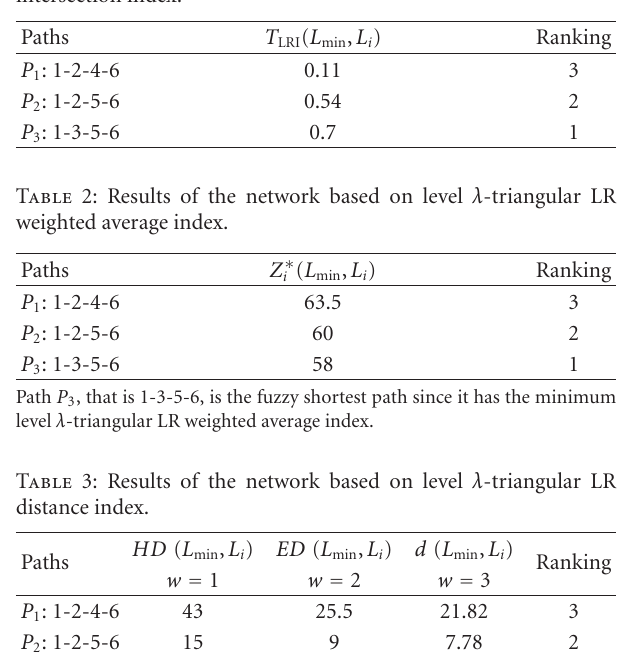
Table 4: Results of the network based on level λ -triangular LR mean and centroid index.